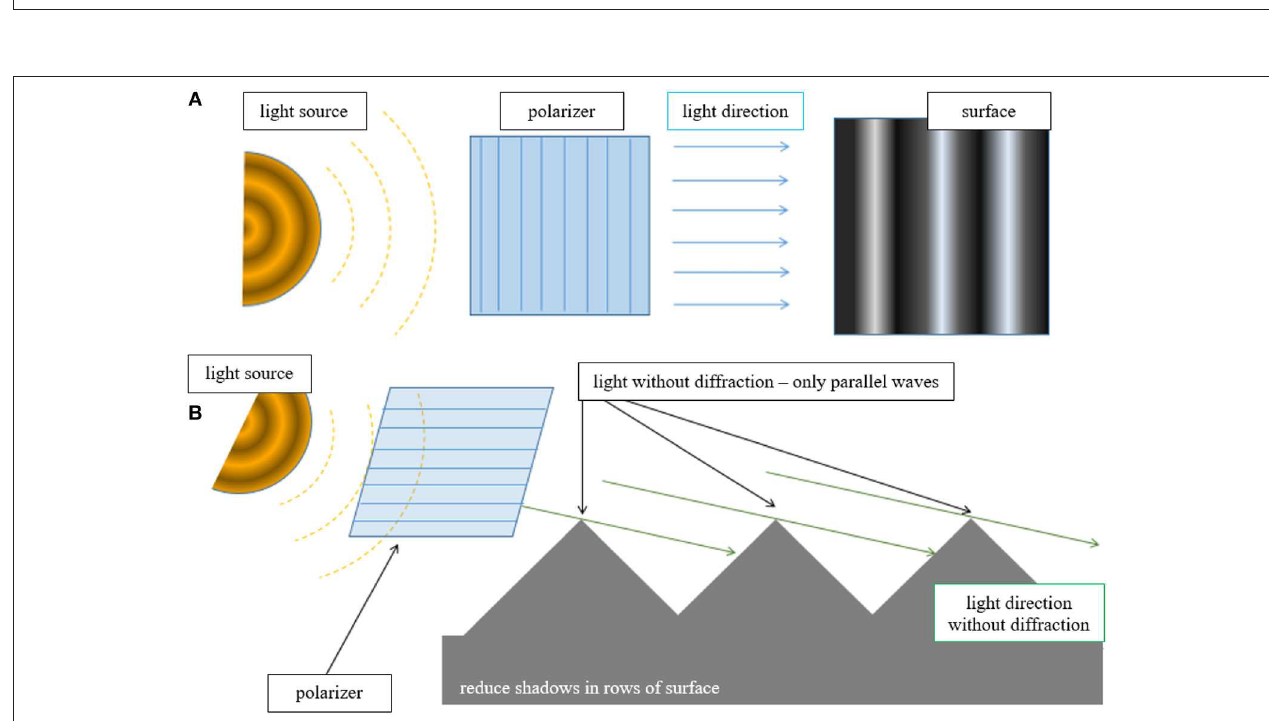
FIGURE 4 | The diagram of polarized light falling on the tested surface: (A) the direction of the light falling on the surface and (B) limitation of light diffraction at the tops of the sample.